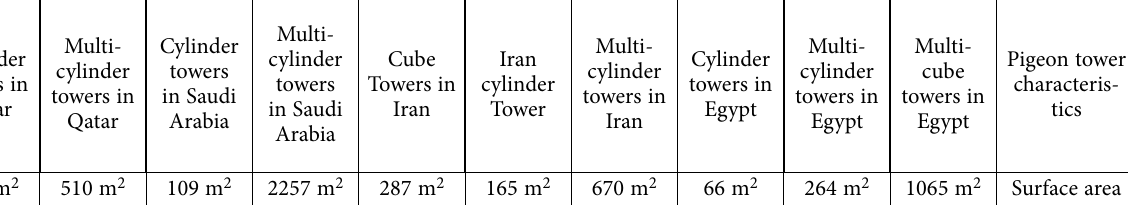
Table 2. Area of the outer surfaces of pigeon towers in Central Asia